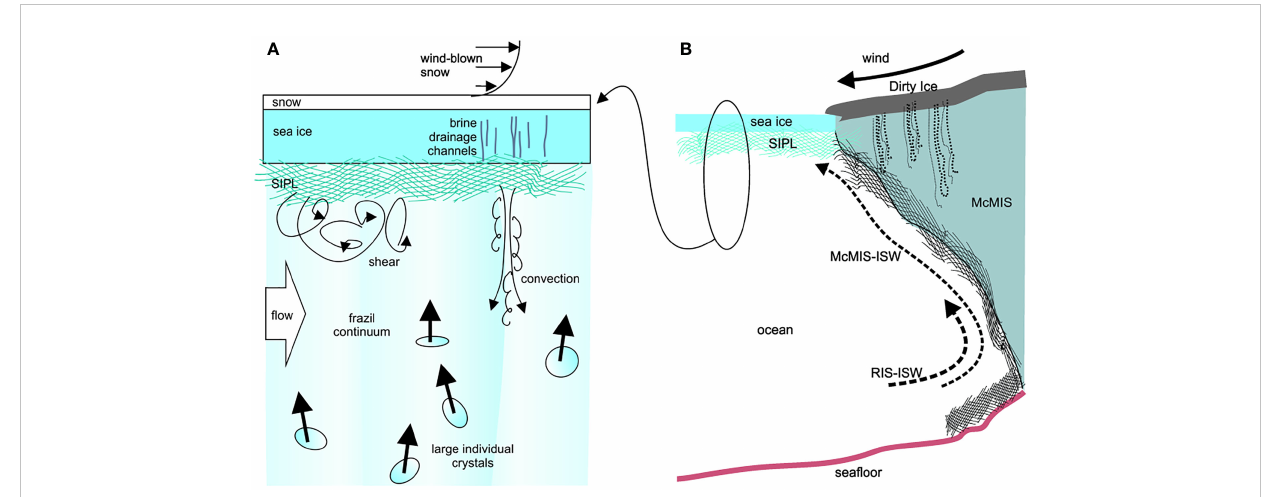
FIGURE 11 (A) Ice/SIPL/Ocean boundary layer structure showing crystals rising through the boundary layer processes. (B) Elevation sketch of the ISW plumes from the McMurdo and Ross cavities and how they might interact with a sea ice